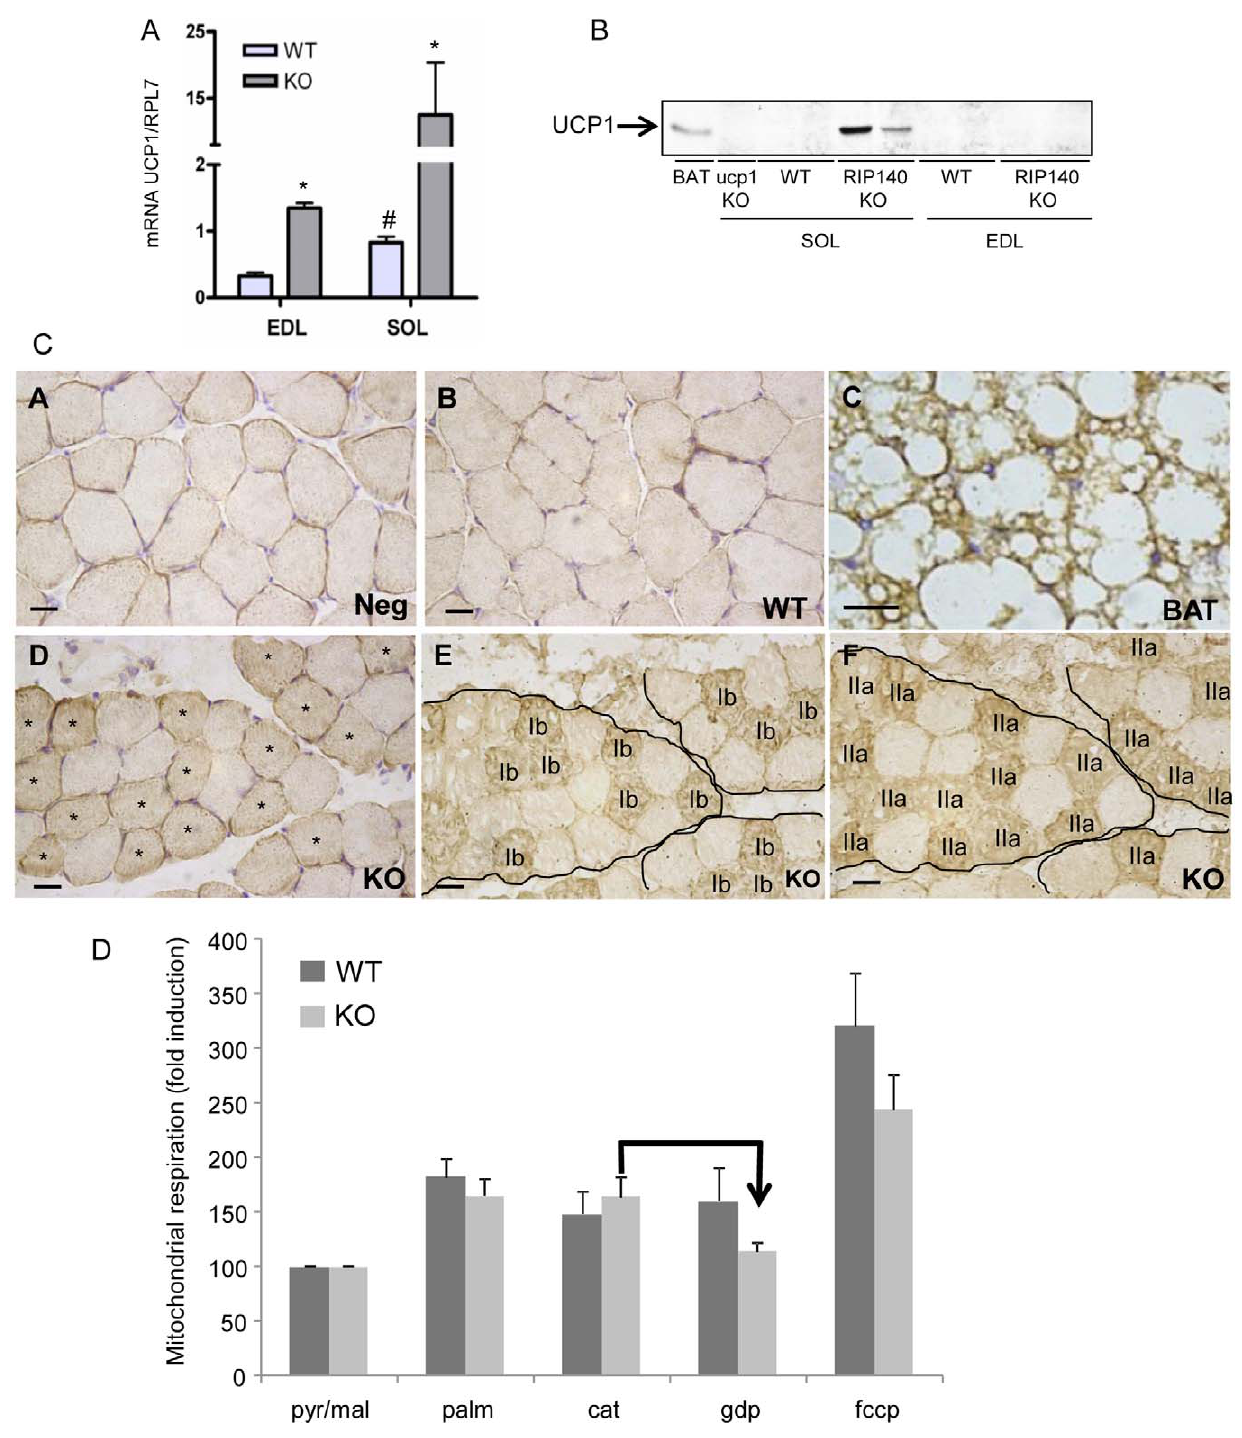
Figure 7. Absence of RIP140 leads to fiber-type specific expression of UCP1 in the soleus. (A) Real-time RT-PCR analysis of UCP1 mRNA level in EDL and soleus (SOL) of RIP140-null (KO) versus WT mice (n=5). Data are expressed as mean 6 SEM, *p , 0.05, WT vs KO; # p , 0.05, WT EDL vs WT soleus. (B) Analysis of UCP1 expression by western-blot on 50 m g of proteins extracted from UCP1-null soleus (ucp1 KO), RIP140-null (KO) and WT soleus, RIP140-null (KO) and WT EDL, except for brown adipose tissue (BAT, 1 m g). (C) Immunohistochemistry for UCP1 on WT and RIP140-null (KO) soleus (panels B and D, respectively) with brown adipose tissue as positive control for UCP1 (BAT, panel C) and WT soleus incubated with primary antibody omitted as negative control (Neg, panel A). Immunohistochemistry for MyHCIb (panel E) and MyHCIIa (panel F) on RIP140-null soleus. *Asterisks represent fibers positive for both UCP1 and MyHCIIa (scale bar=100 m m). (D) Respiration of skinned myofibers isolated from RIP140-null (KO) and WT soleus was monitored after successive addition of pyruvate/malate (pyr/mal), palmitate (palm), carboxyatractylate (cat), gdp and fccp. Data are expressed as fold induction 6 SEM, with respiration after addition of pyruvate/malate set to one for both RIP140-null and WT conditions.